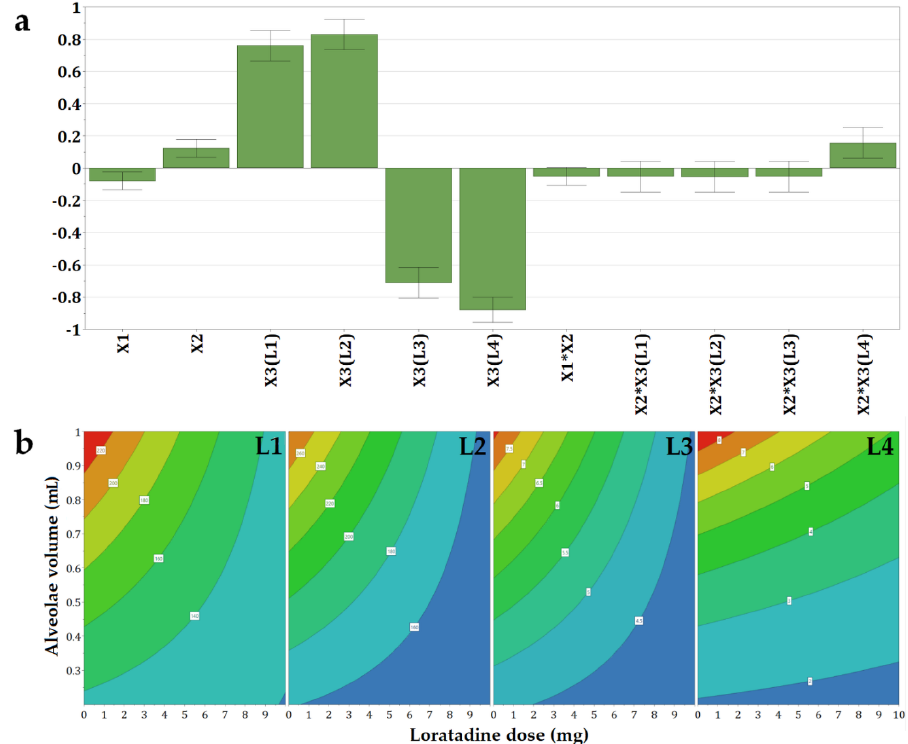
Figure 2. Coefficients of the regression equations displayed as ( a ) histograms and ( b ) representative contour plots for the disintegration time (Y1) as a function of the three independent variables.